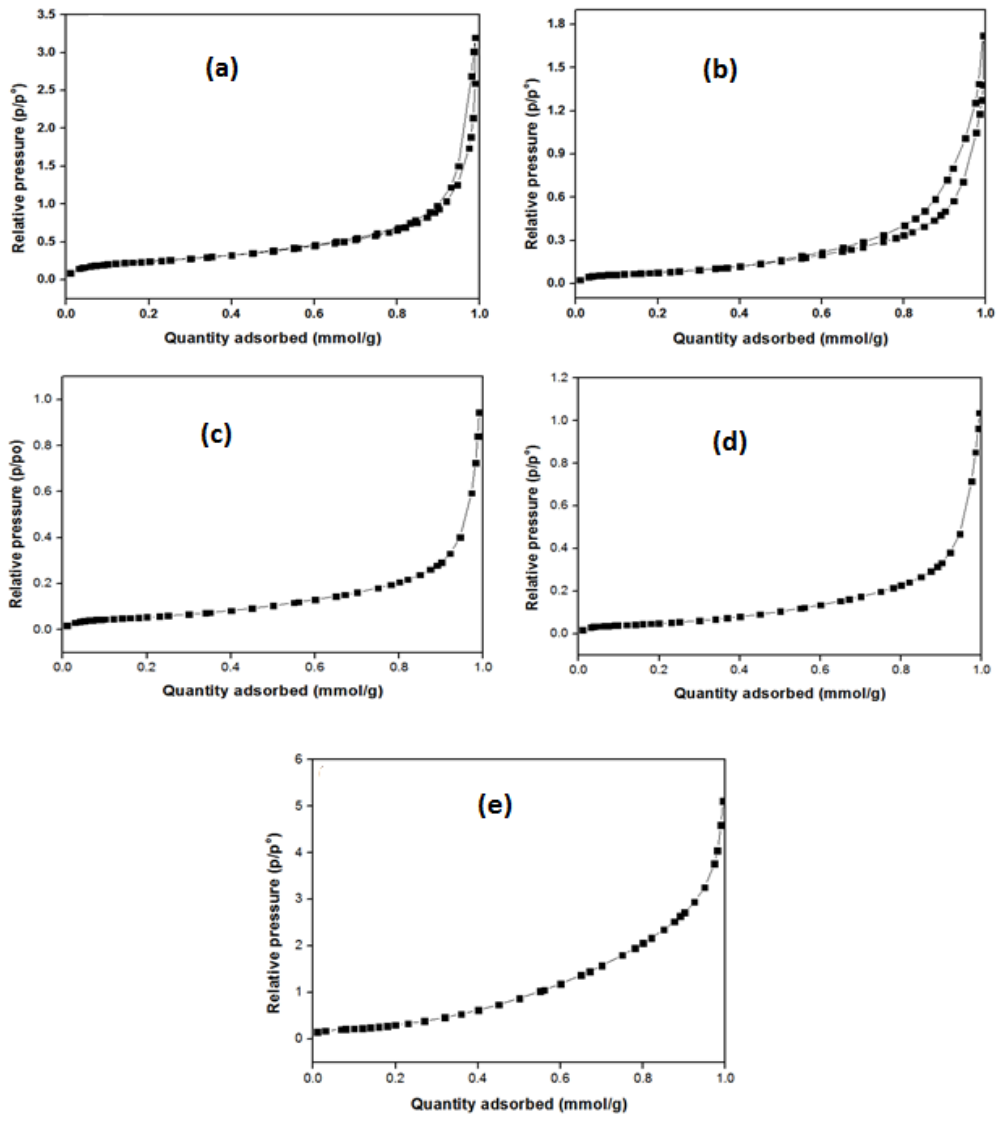
Figure 4. Adsorption-desorption isotherm for ( a ) Dolomite ( b ) 5 wt% K / D ( c ) 10 wt% K / D ( d ) 15 wt% K / D. ( e ) 20 wt% K / D.